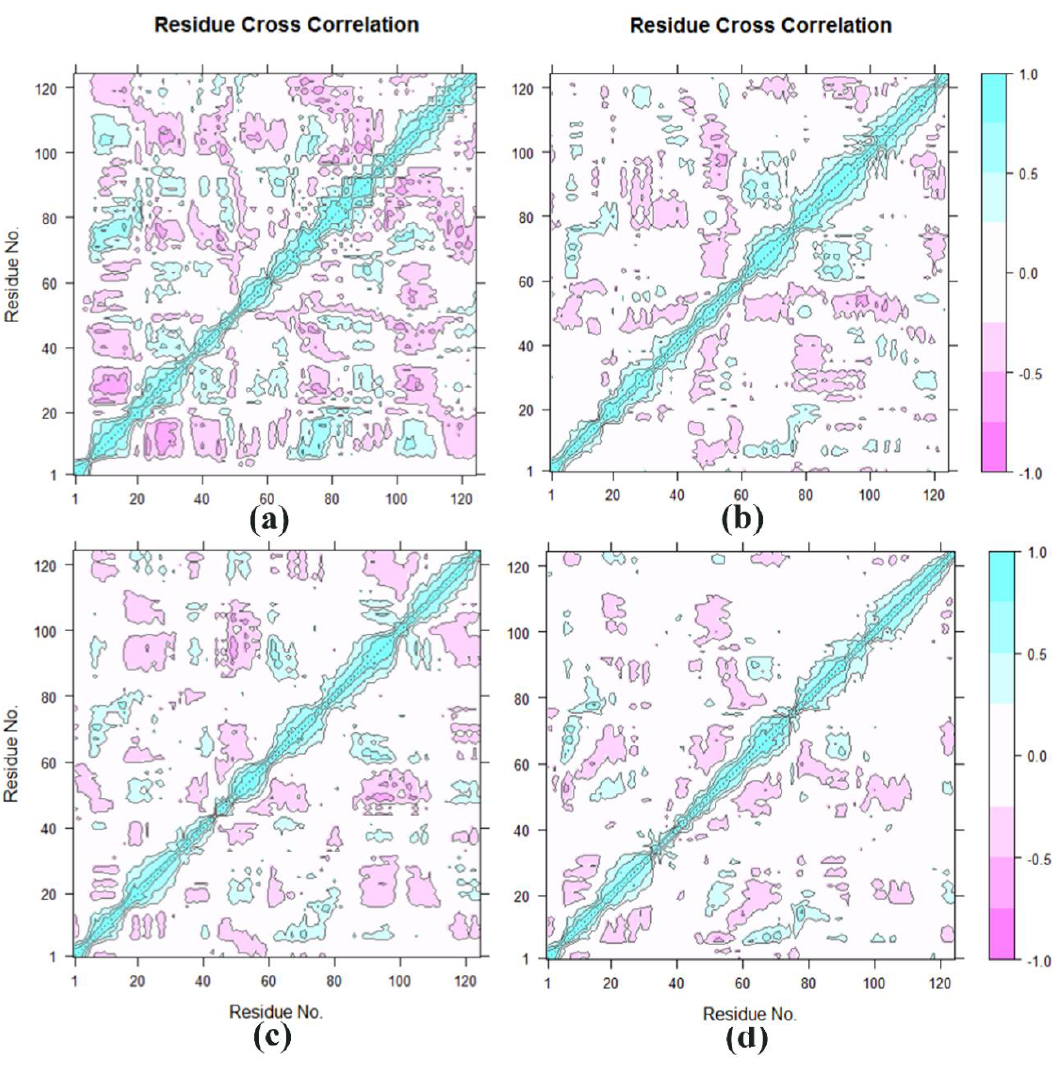
Figure 6. Cross-correlation matrix of the fluctuations of each of the x, y and z coordinates of the C α atoms from their average during 150 ns MD for ( a ) the Free-BRD4 with the prosthetic group, ( b )BRD4-Cpd4, ( c )BRD4-Cpd9, and ( d ) BRD4-Cpd19.